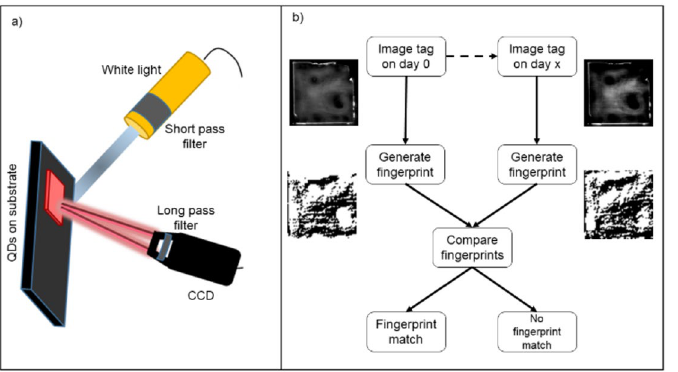
Figure 1. ( a ) A schematic of the apparatus used to measure PL intensity maps and to captures images of each token. The quantum dots in each token were excited using white light filtered through a 450 nm short-pass filter. A 500 nm long-pass filter placed in front of the CCD ensures only light from the emission of the QD-PUF is measured. The entire apparatus is sealed within a closed black box when measurements are in progress. ( b ) Using the apparatus in ( a ) each token is imaged on the day of its creation and each subsequent day after. The fingerprint generated on the subsequent days is compared to that of day 0 to determine if it matches the original